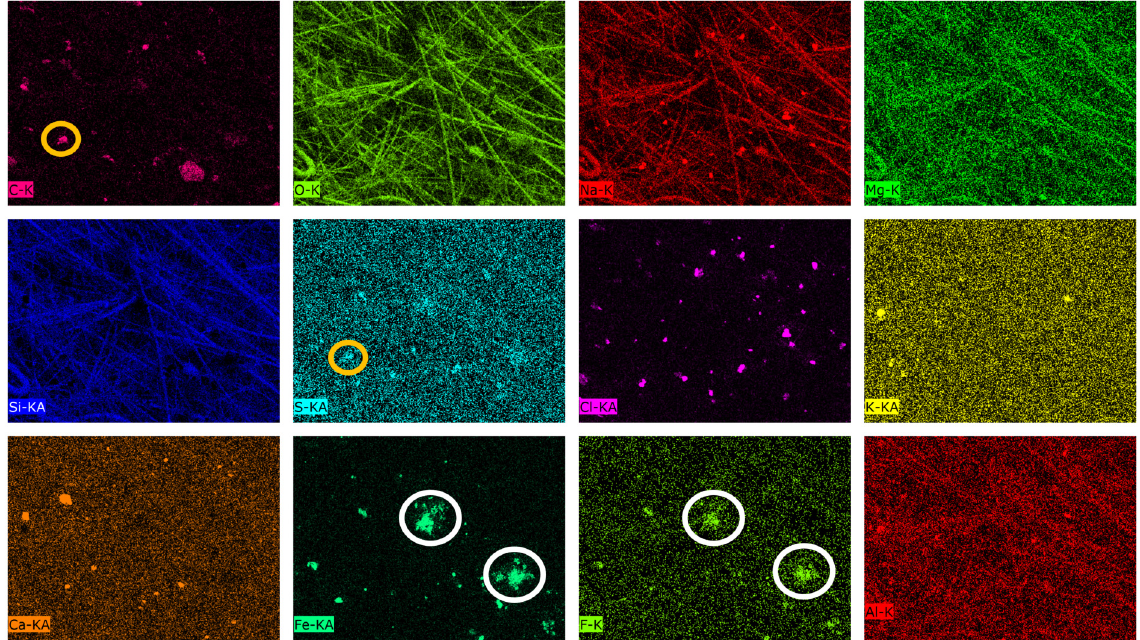
Figure 15. EDX-Map—Elemental analysis of a filter area at the main traffic intersection, with brake particles (white) and tyre particles (yellow) marked; subfigures show individual chemical elements.